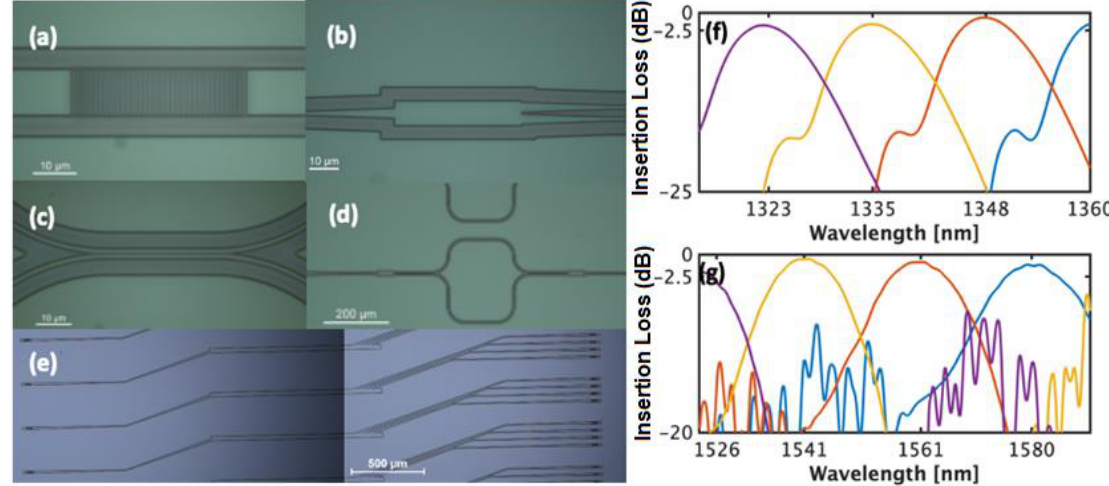
Figure 14. Si nitride device library: ( a ) grating coupler; ( b ) multimode interferometer; ( c ) directional coupler, ( d ) Mach–Zehnder interferometer; ( e ) angled-multimode interferometer (reprinted from [95], The Optical Society, 2017); ( f ) (de)multiplexer response in the O-band and ( g ) (de)multiplexer response in the C-band.